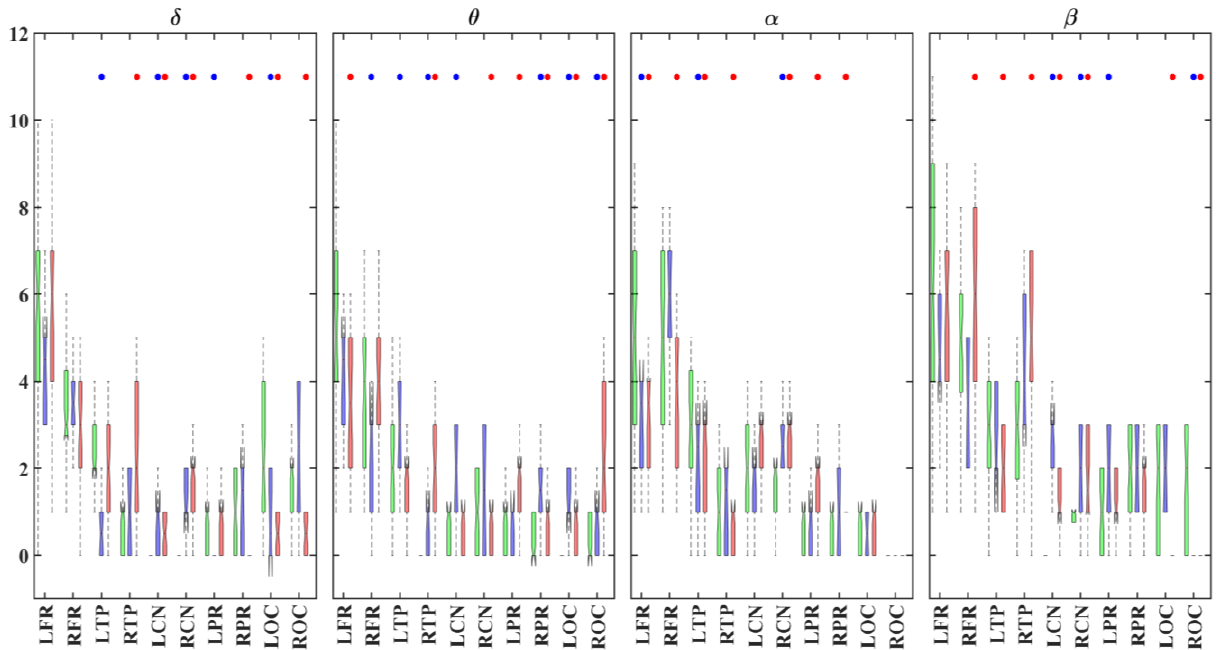
Figure 6. Boxplots displaying the median and interquartile ranges of the number of rich clubs for each brain region and group (TD: green; ADHD I : blue; ADHD C : red) in different frequency bands. The points indicate statistically significant differences ( p < 0.05, 1000 permutations) between the ADHD C and TD (red) groups and between the ADHD I and TD (blue) groups. R/L: right/left; FR: frontal regions; TP: temporal regions; CN: central regions; PR: parietal regions; OC: occipital regions.